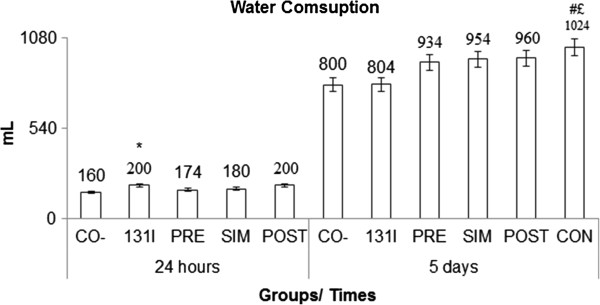
Water consumption by animals exposed to different antimutagenic treatments that were sacrificed 24 hours or 5 days after the administration of 131I. Groups: Negative control: CO-; Iodine-131: 131I (Results published in [5]). Antimutagenic Treatments: SIM: simultaneous; PRE: pre-treatment; POST: post-treatment; CON: continuous. * Statistically significant result compared with 24-hour negative control (p < 0.001). # Statistically significant result compared with 5 days negative control (p < 0.01). £ Statistically significant result compared with treatment with 131I and sacrifice after 5 days (p < 0.001).